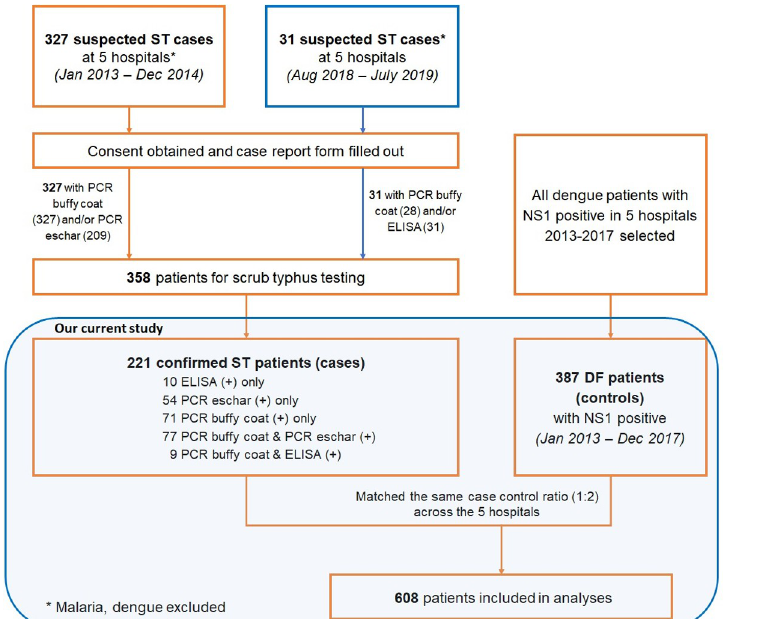
Fig 1. Investigational procedures and protocol for patients included in the